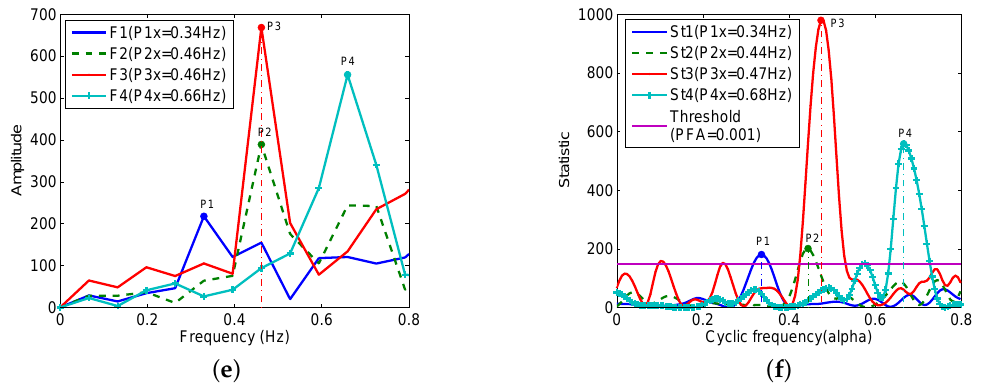
Figure 10. Estimated respiration frequencies and statistic of the received recorded respiration signal under the four different tempos. ( a ) TOCCs of R1, R2, R3, R4 (distance = 30 cm); ( b ) Fourier spectrum (distance = 30 cm); ( c ) Test statistic of ( a ); ( d ) TOCCs of R1, R2, R3, R4 (distance = 50 cm); ( e ) Fourier spectrums (distance = 50 cm); ( f ) Test statistic of ( d